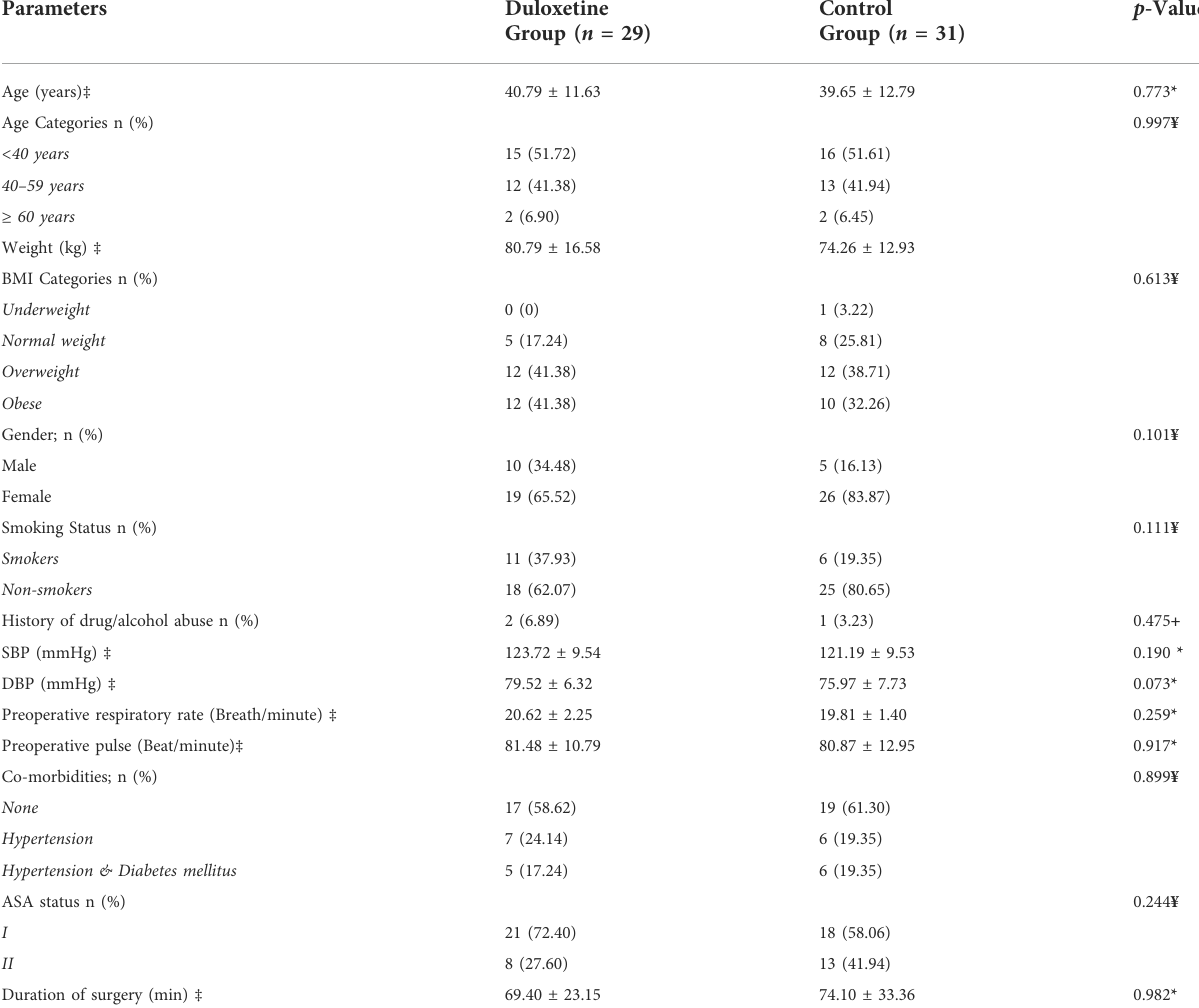
TABLE 2 Baseline demographic and clinical variables of the two study